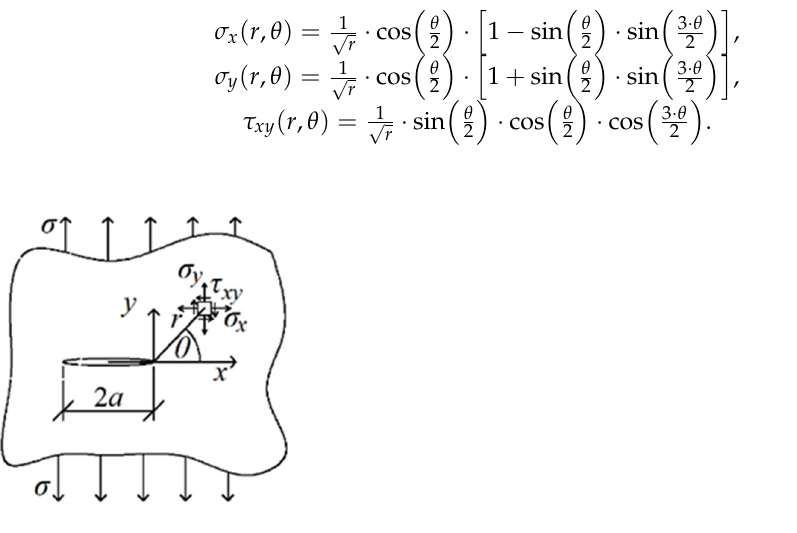
Figure 2. Griffith’s crack.